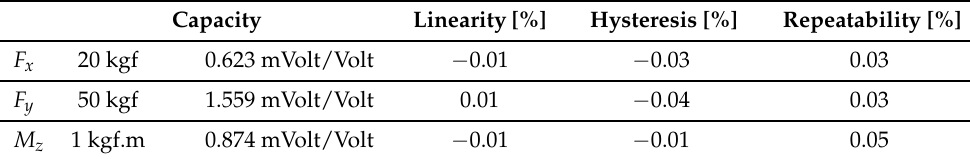
Figure 1. Schematic of the experimental set-up. Three component dynamometer, high speed cameras and the wall-mounted pressure transducers are synchronized via a LABVIEW interface. Table 1. Performance characteristics of the